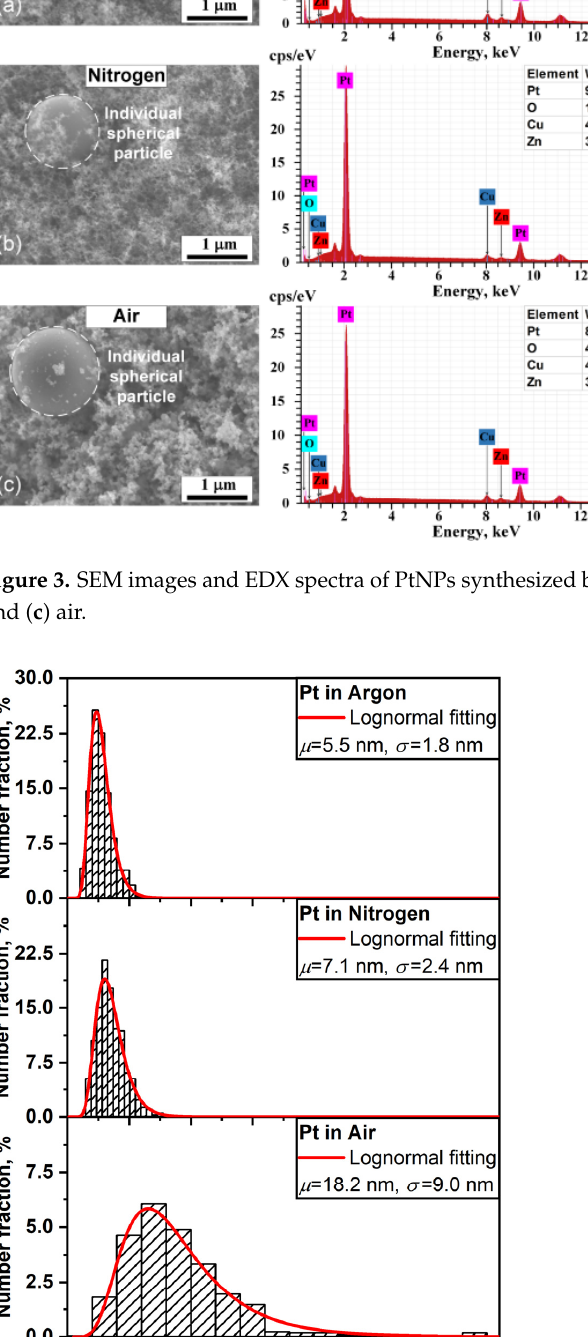
Figure 4. Histograms of the particle size distribution of primary Pt nanoparticles synthesized by spark discharge under Ar, N 2 , and air. Histograms are determined from TEM images and approximated by a lognormal function.